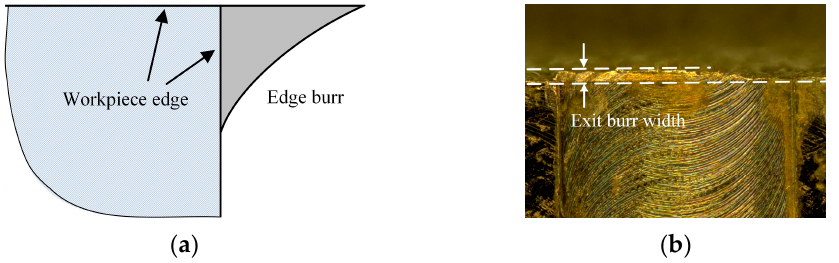
Figure 2. Exit burr definition and width measurement. ( a ) Exit burr definition. ( b ) Exit burr width measurement.